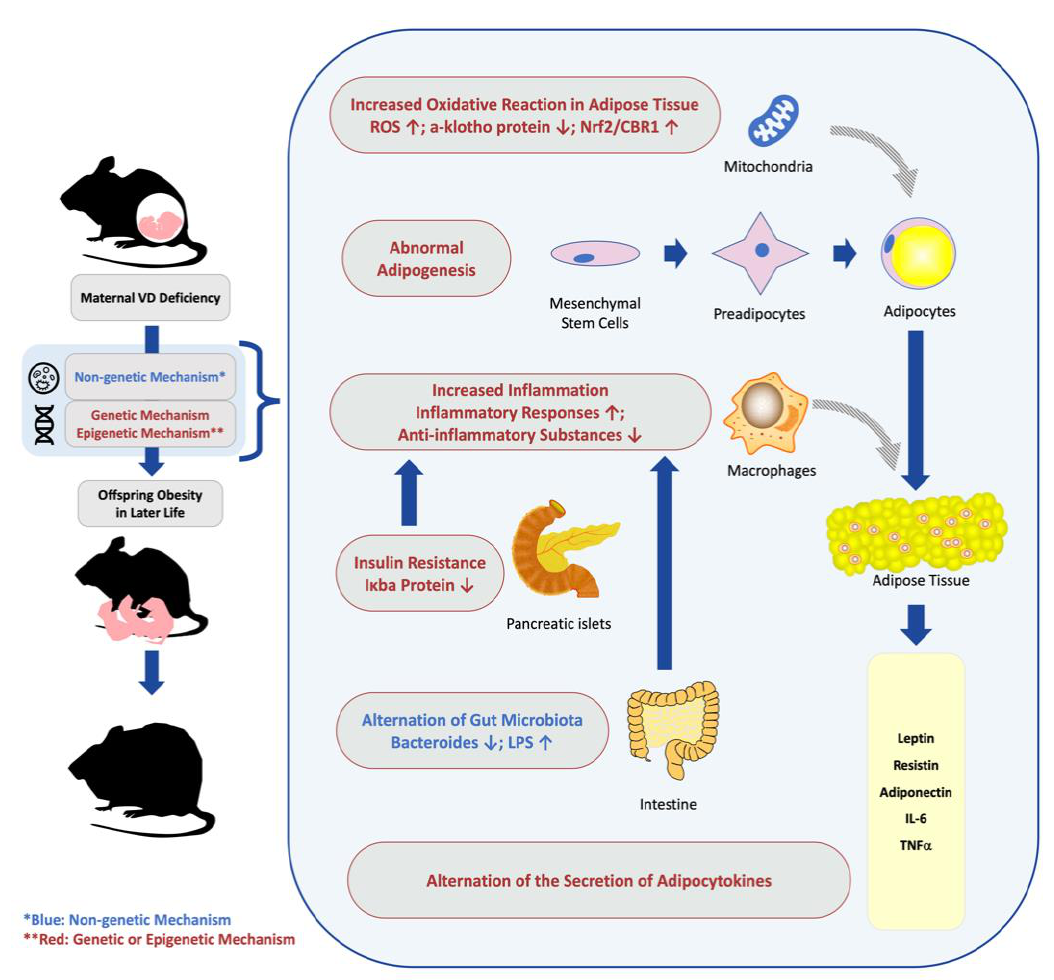
Figure 1. The mechanism on the effect of maternal VD deficiency on offspring obesity. Maternal VD deficiency increases vulnerability of offspring obesity through non-genetic mechanisms, genetic changes, and epigenetic alternations, such as increasing inflammation and oxidative reactions, affecting adipogenesis and adipocytokine secretion, and altering gut microbiota. VD Supplementation during pregnancy for women with VD deficiency may attenuate the negative metabolic outcomes in the offspring under medical guides. VD, vitamin D; IL-6, interleukin 6; TNF- α, tumor necrosis factor - α; ROS, reactive oxygen species; CBR1, carbonyl reductase 1; Nrf2, nuclear factor-erythroid factor 2-related factor 2; LPS, lipopolysaccharide; Iκbα, nuclear factor κB inhibitor α.